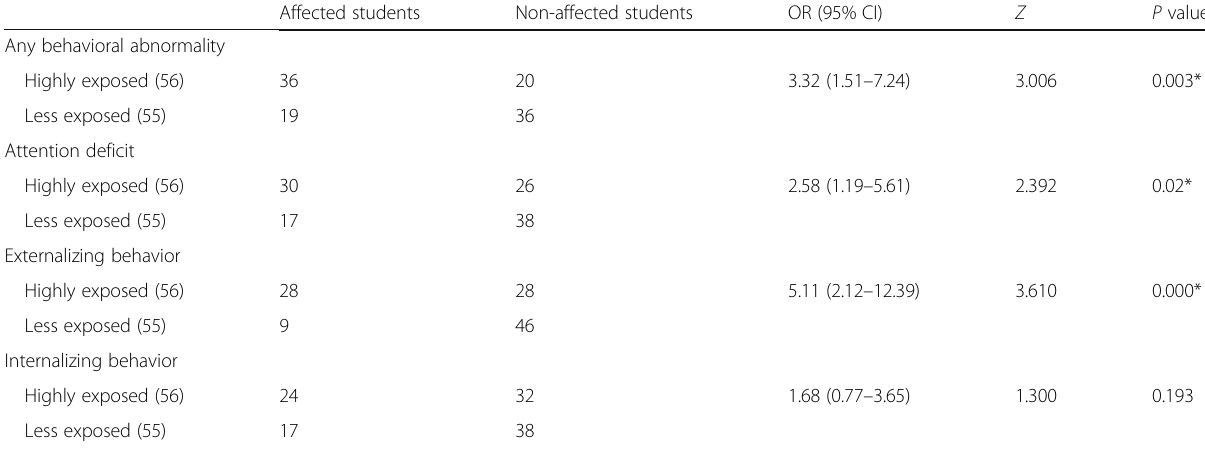
Table 5 The risk of behavioral problems in relation to exposure to multiple